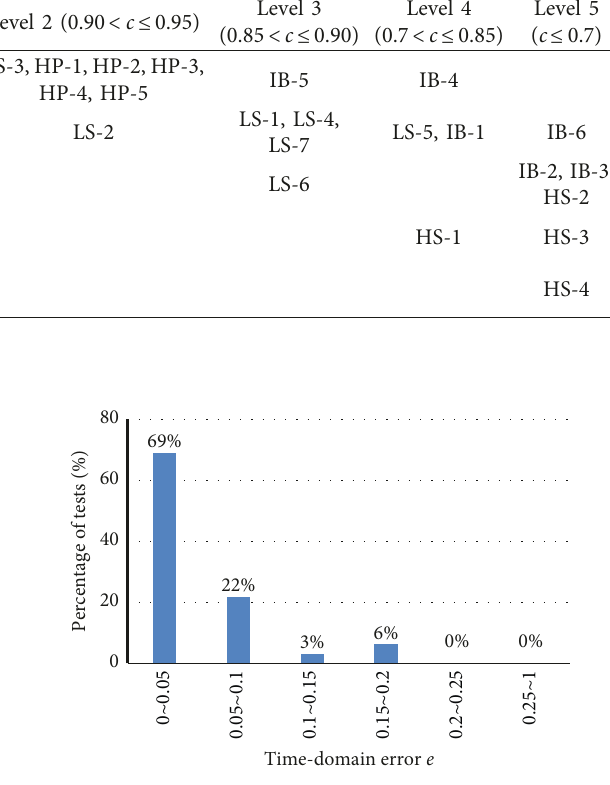
Figure 31: Time-domain error distribution diagram of different test